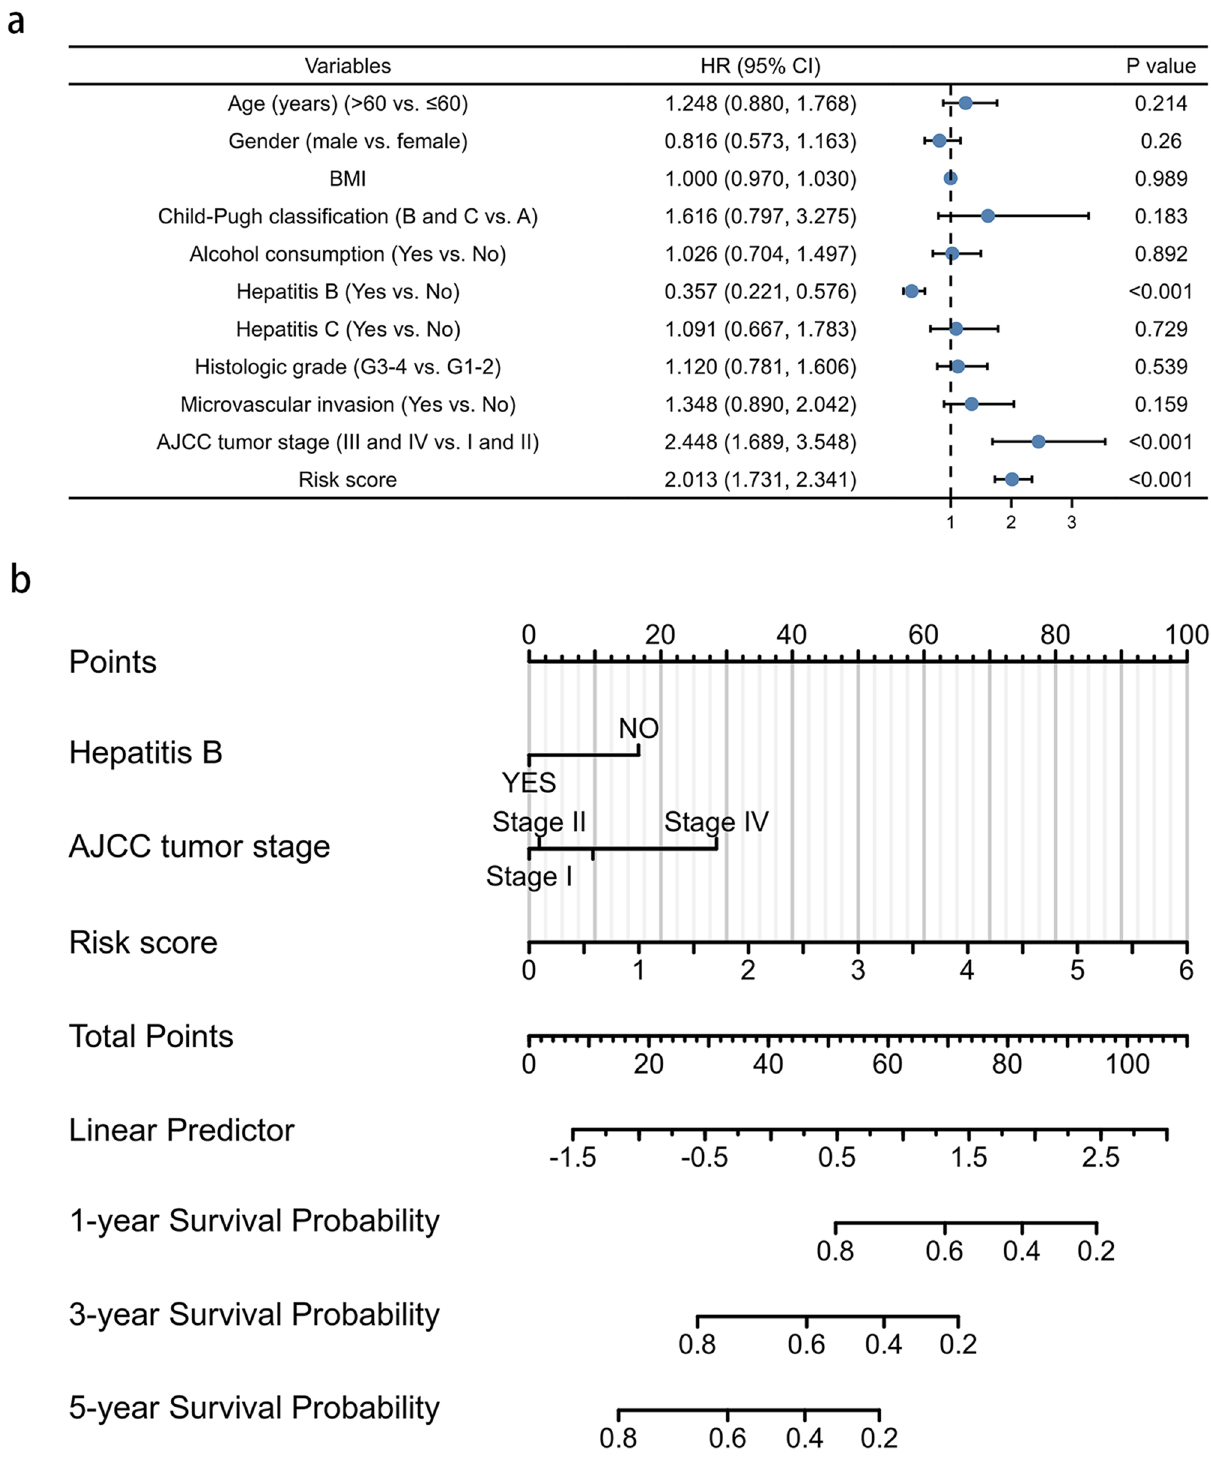
Figure 5. The prognostic values of pyroptosis-related lncRNA signature. ( a ) Multivariate Cox regression of patient characters and the signature in the whole cohort. ( b ) The nomogram constructed using patient characters and the